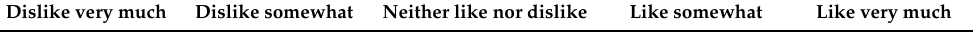
Table 2. Five-point hedonic scores given for the studied wines.